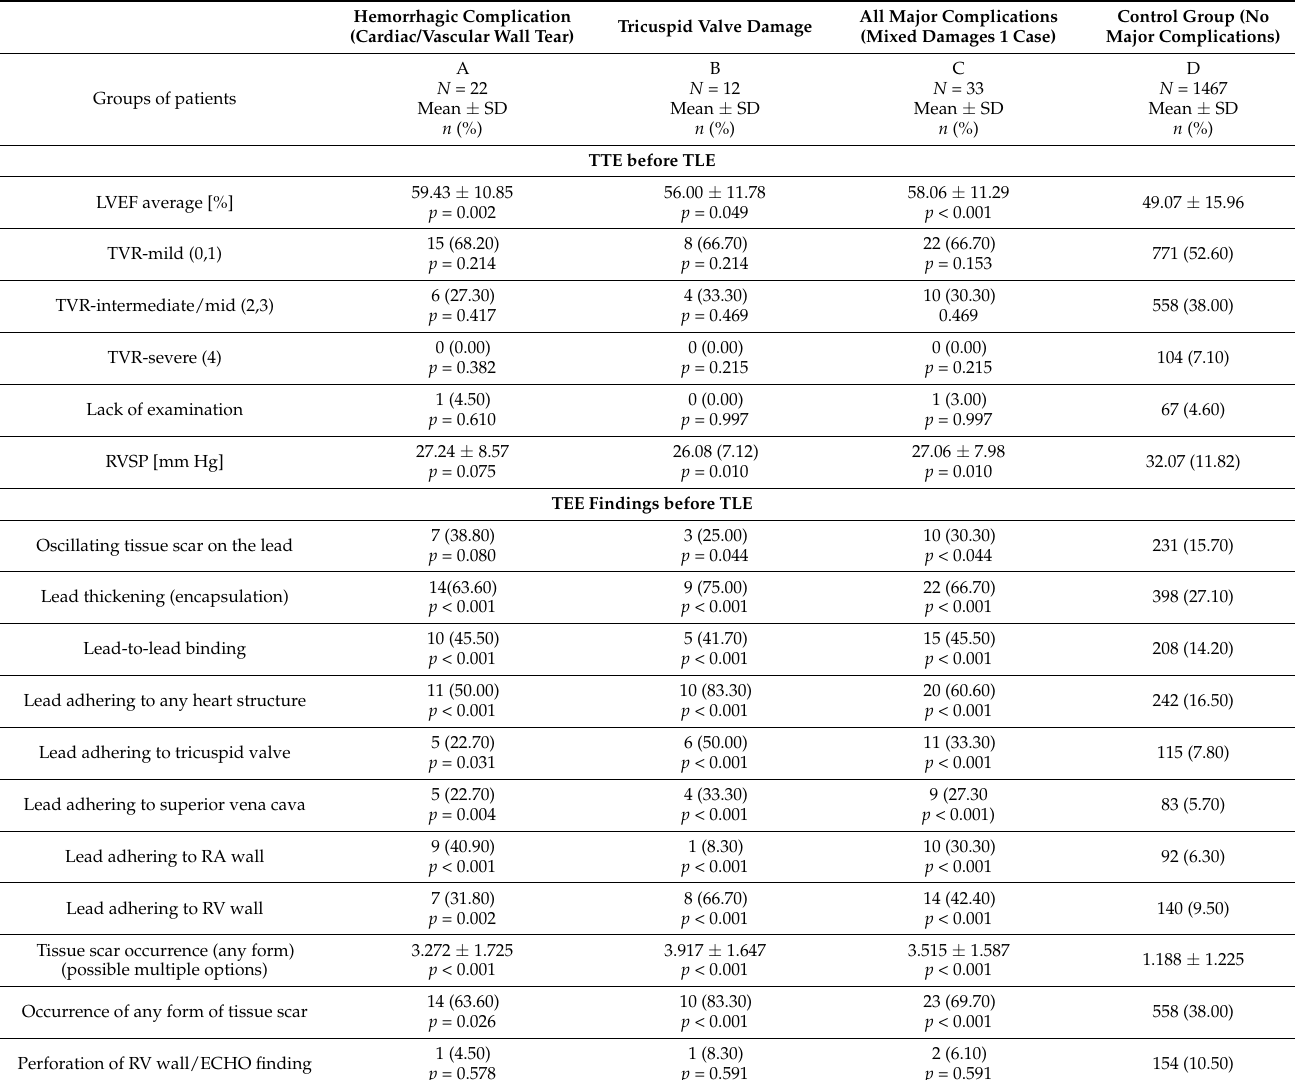
Table 3. TTE and TEE before